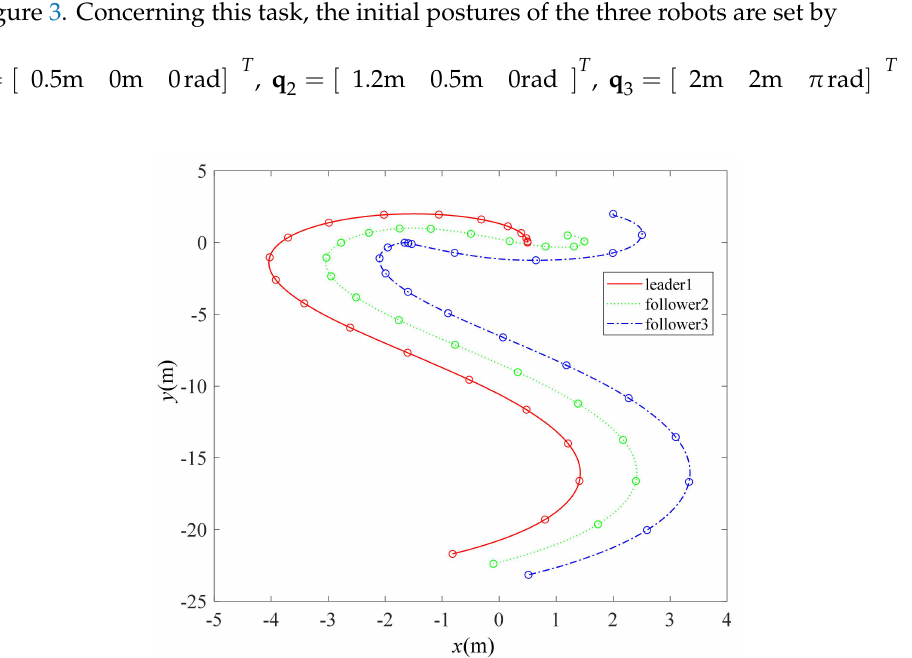
Figure 9. String formation of the platform when moving along an S-shape